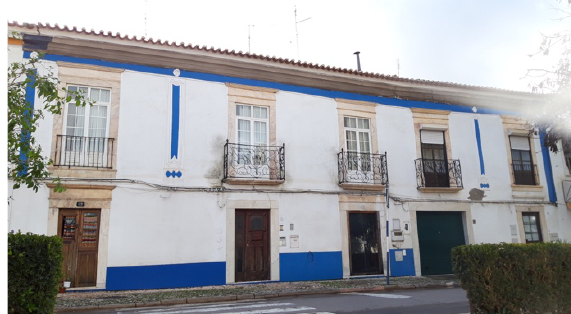
Figure 3. Façade of house in Largo dos Combatentes, 25, Borba. (Rosado,